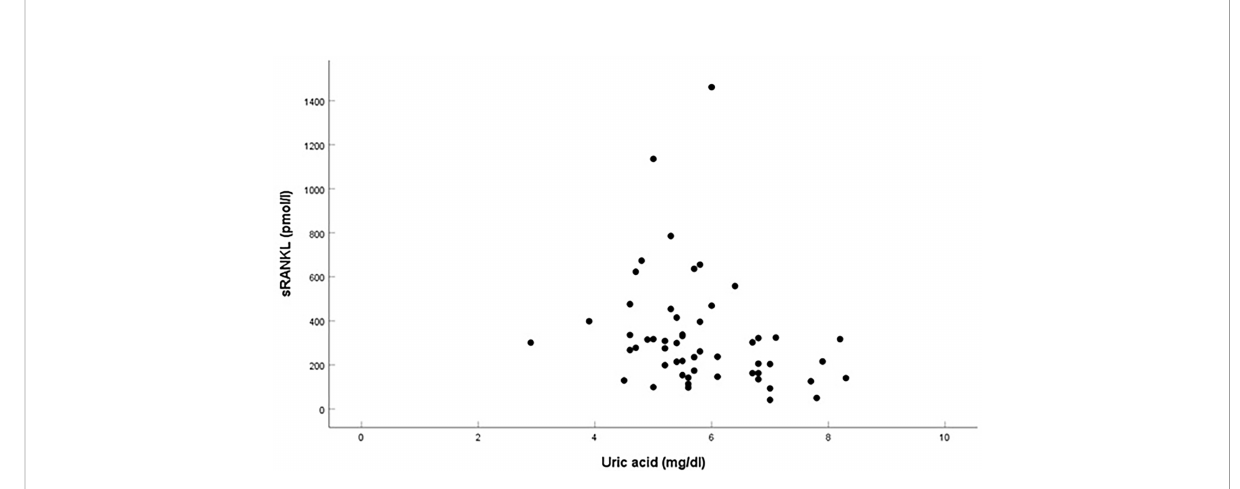
FIGURE 1 Correlation between sRANKL and urid acid in overweight and obese